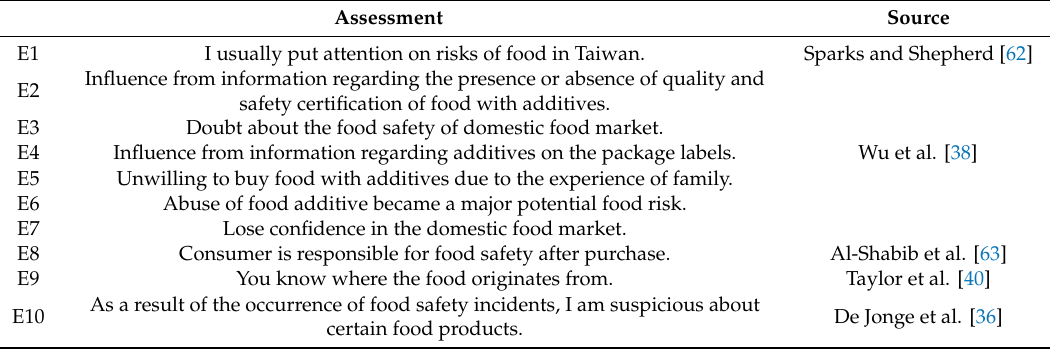
Table 4. Indicators of food safety gap between consumers’ expectation and actual perceived. Assessment